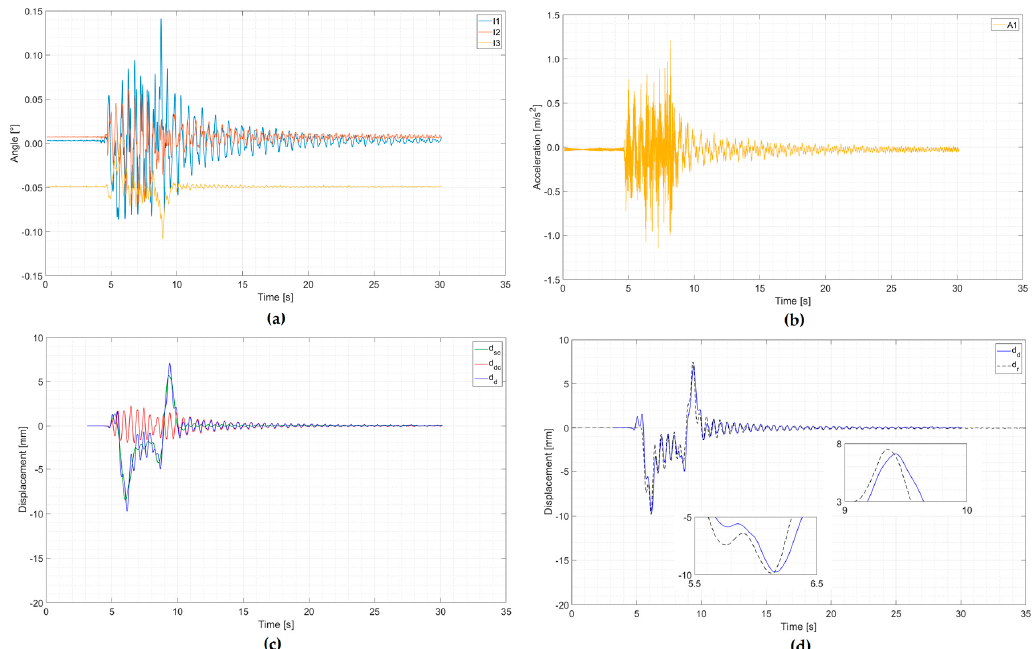
Figure 12. An example of an analysis of a multiple-unit train passage with a speed of about 190 km / h: ( a )Signalsfrominclinometers; ( b )signalfromanaccelerometer; ( c )determinedquasi-staticdisplacement component (from inclinometers) d sc , dynamic displacement component (from an accelerometer) d dc , and total dynamic displacement d d ; ( d ) comparison of total dynamic displacement d d with reference measurement d r (zoom of max and min values).